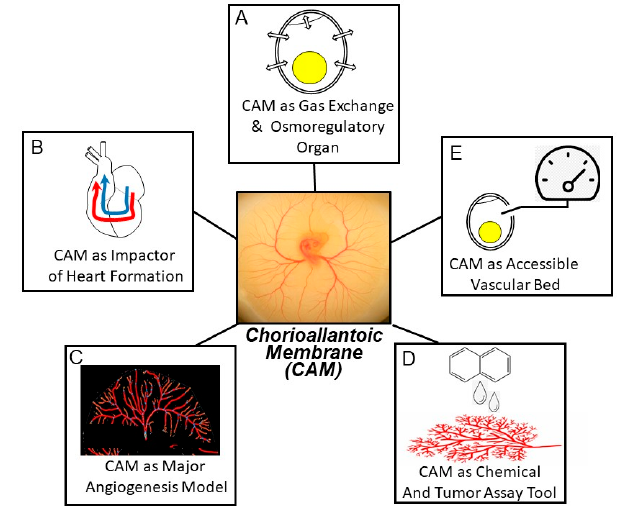
Figure 1. Some examples of major themes in chorioallantoic membrane (CAM) research involving respiratory gas and ion and water exchange ( A ), cardiac development ( B ), angiogenesis ( C ), toxicology and oncology ( D ), and general physiology ( E ). See text for additional discussion.